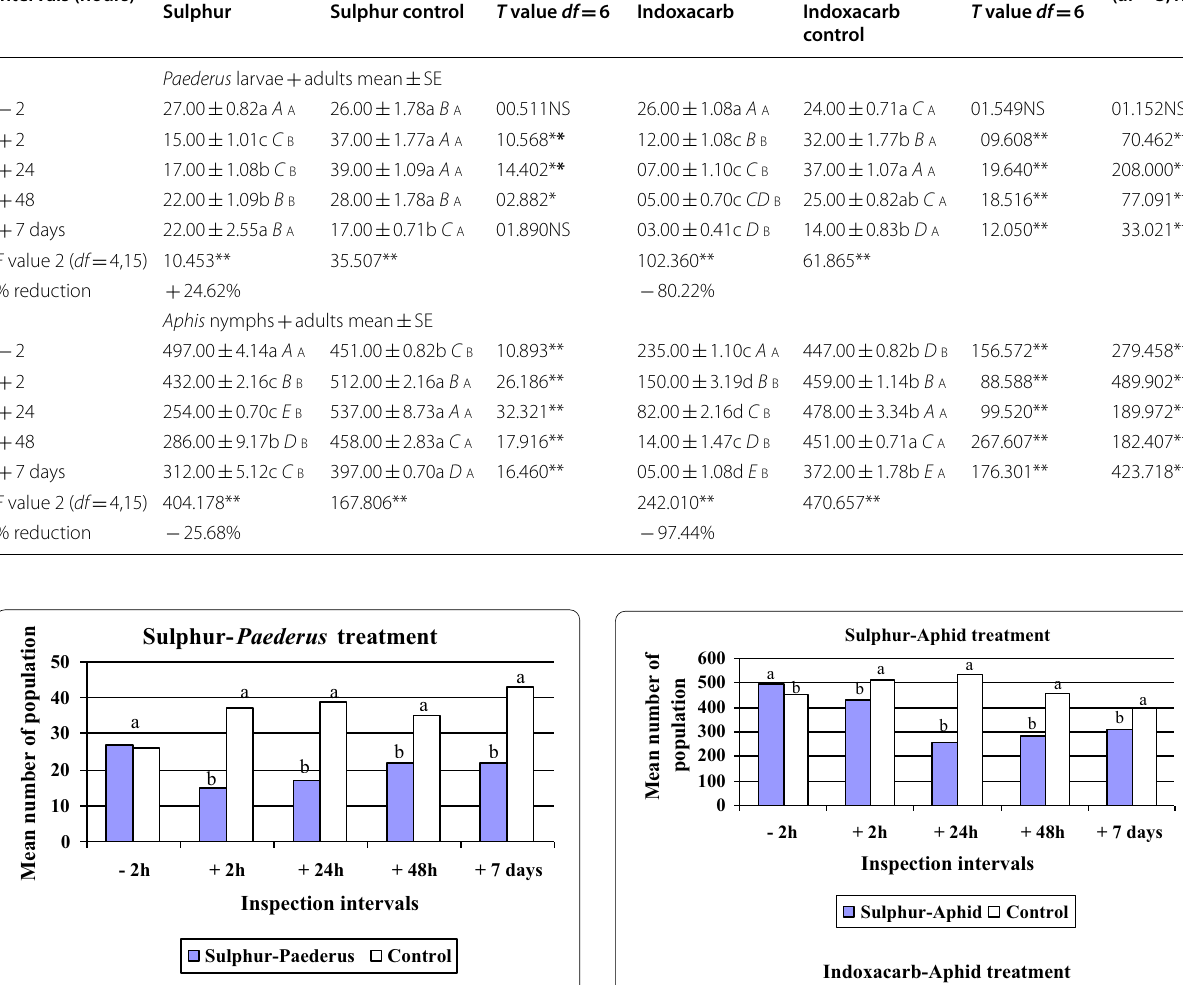
Table 3 Effect of indoxacarb and sorell 98% treatments on the population density of Paederus and Aphis movable stages Inspection intervals (hours)